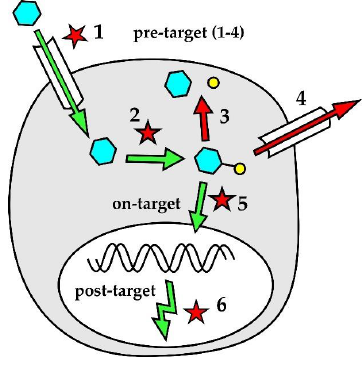
Figure 2. Cell-intrinsic mechanisms of drug resistance. 1. Inhibition of active drug transport within the lymphoma cell; 2. Inhibition of pro-drug activation into active metabolite(s); 3. Increased drug degradation; 4. Increased drug efflux; 5. Interference with drug mode of action, e.g., increased DNA repair; 6. Disruption of DNA damage response pathways.